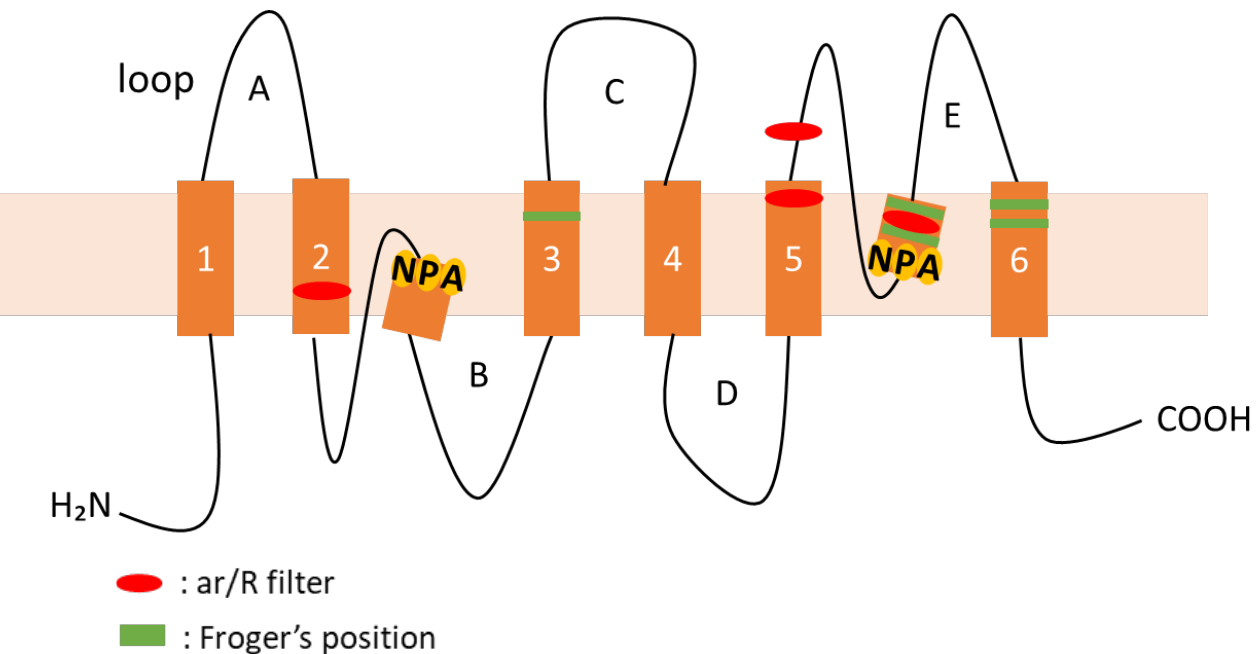
Figure 1. Schematic representation of the classical structure of AQPs. An AQP monomer showing the six transmembrane helices (1–6) connected by two intracellular (loop B and D) and three extracel- lular (loop A, C, and E) loops. The conserved residues from the first selective filter (NPA motifs) and the second filter (ar/R filter) are shown in yellow and red, respectively. Froger’s positions are shown in green, respectively.